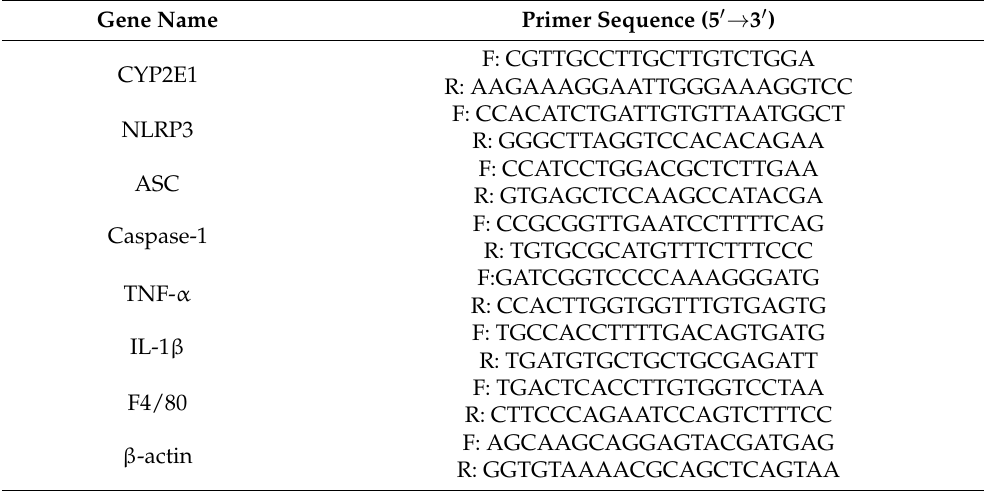
Table 2. Mouse primer sequences for